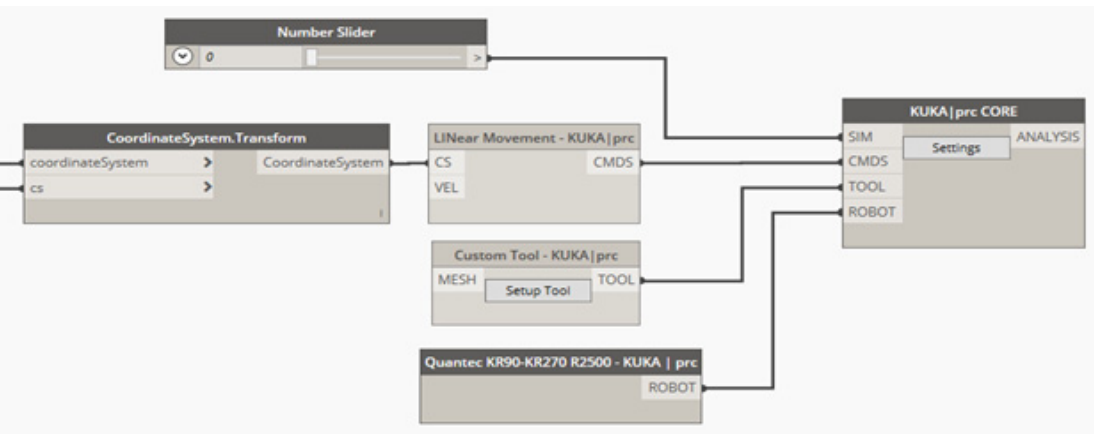
Figure A10. Control nodes for the KUKA TM robotic arm.